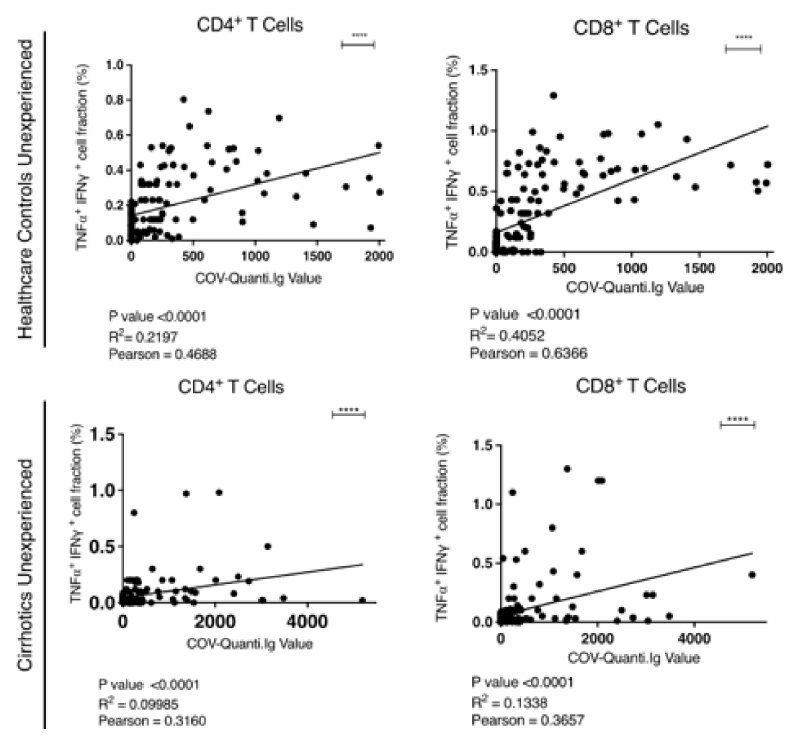
Figure 5. Correlation analysis between the anti-SARS-CoV-2 IgG levels and the abundance of CD4+ and CD8+ SARS-CoV-2–reactive T cells in peripheral blood mononuclear cells (PBMCs) from HW and cirrhotics patients. (**** indicates statistically significant